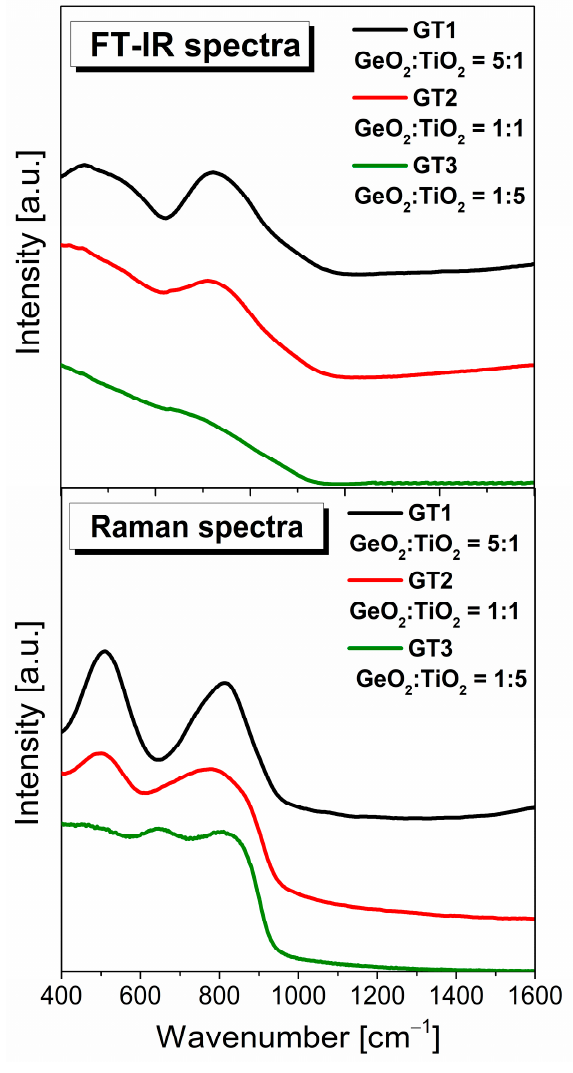
Figure 8. Infrared and Raman spectra of the investigated samples with GeO 2 /TiO 2 ratio (5:1, 1:1, and